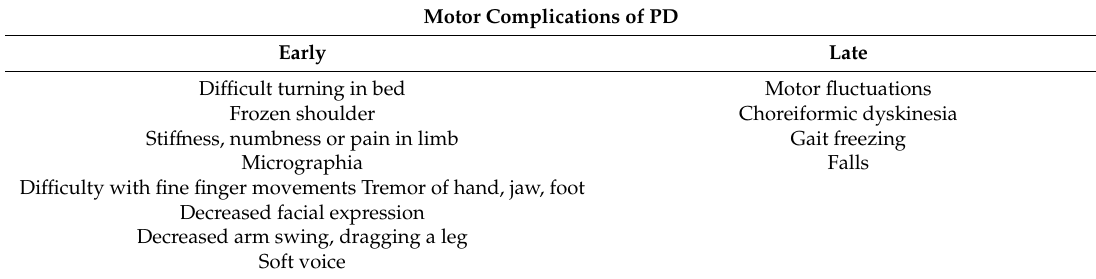
Table A1. Overview of symptoms / complications associated with idiopathic PD